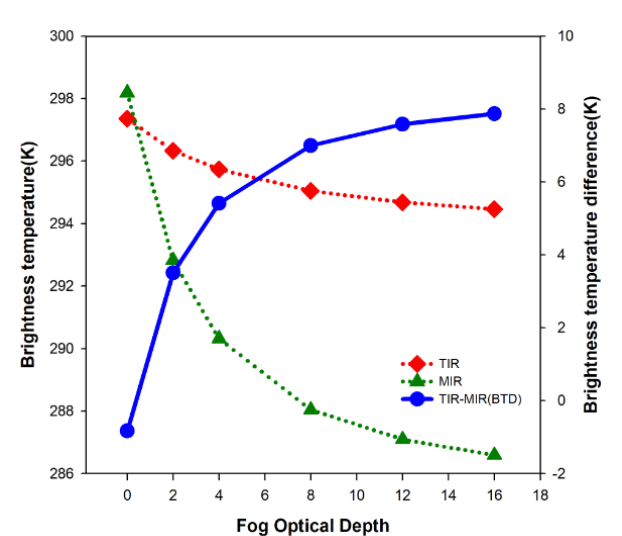
Figure 3. BT (K) and BTD (K) variation with FOD